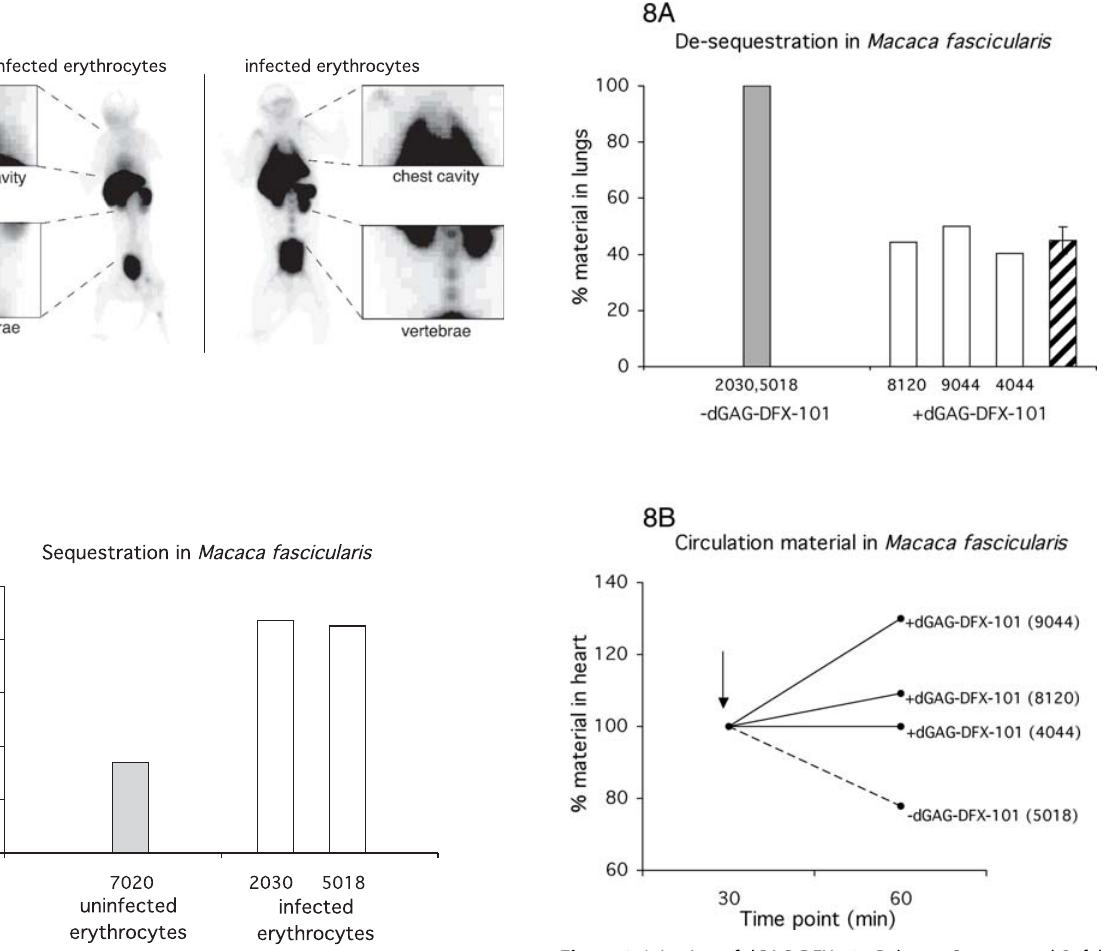
Figure 8. Injection of dGAG-DFX-101 Releases Sequestered P. falciparum IE into Circulation in M. fascicularis Five macaques (M. fascicularis) were injected with 99m Tc-labeled IE of the parasite FCR3S1.2 and left for 30 min. Three of the monkeys (ID 8120, 9044, and 4044) each received 500- l g dGAG-DFX-101 by intravenous injection while two monkeys (ID 2030 and 5018) were left untreated. (A) Shows the level of material in the lungs. The dGAG was injected at time point 30 min and the radioactivity in the animals were measured for 15 min 60 to 75 min after injection. The level of radioactive material in the lungs was compared with the amount of radioactive material in the whole animal. Results are presented as relative amount in lungs compared with control animal receiving no dGAG-DFX-101 (control, adjusted to 100%; grey bar). White bars show the relative amount of material in individual monkeys, and the striped bars, the mean thereof. (B) Shows the level of material in the hearts before and after the injection of the dGAG-DFX-101. The radioactive material in the hearts (i.e., in circulation) increases (9%, ID 8120; 30% ID 9044; and 0% ID 4044) after treatment with dGAG-DFX-101. In contrast, the amount of material in the heart of the monkey left untreated decreased by 22% (ID 5018). The analysis of the radioactivity in the hearts was performed by comparing amounts of material present at time point 30 min and at time point 60 min, after the dGAG-DFX-101 was injected. Time point 30 min was adjusted to 100%. The arrow shows the time point of injection of the dGAG-DFX-101. DOI: